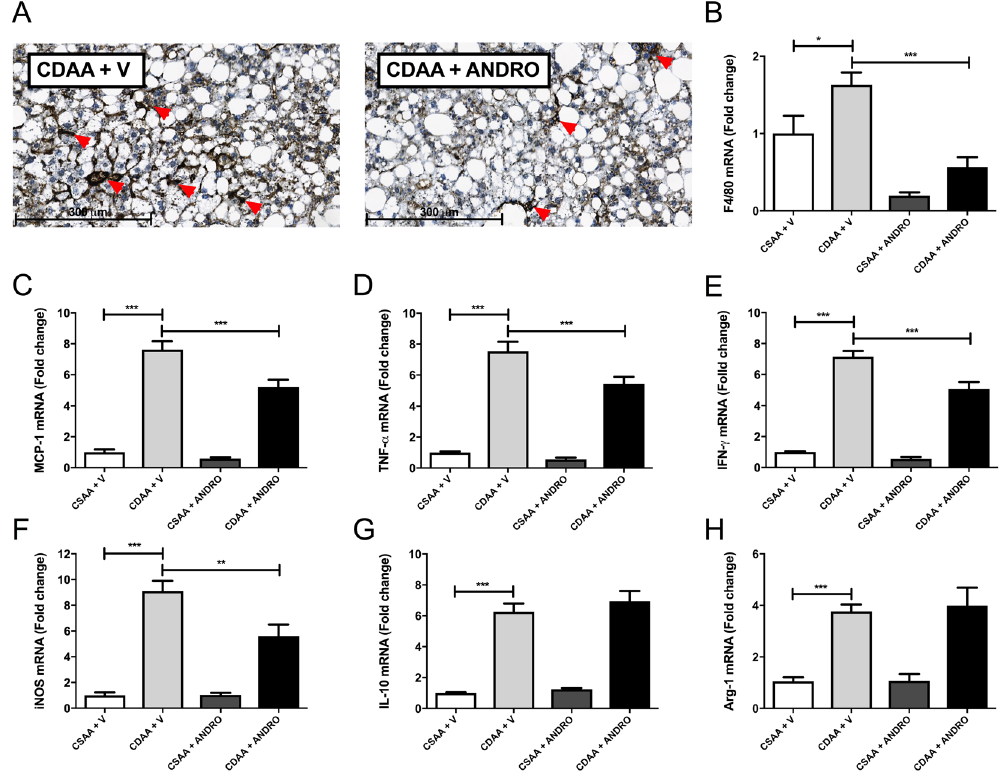
Figure 4. Andrographolide (ANDRO) alleviates CDAA-diet-induced inflammation. Mice were fed with choline-deficient amino acid-defined (CDAA) or choline-supplemented L-amino acid defined (CSAA) diets during 22 weeks and treated with ANDRO or Vehicle (V) as described in material and methods. ( A ) Immunohistochemistry of liver sections using anti-F4/80 antibody, red arrows show inflammatory foci. Hepatic mRNA levels of (B) F4/80, (C) Monocyte chemotactic protein 1 (MCP-1), (D) Tumor necrosis factor-alpha (TNF- α ), (E) Interferon gamma (IFN γ ), (F) inducible nitric oxide synthase (iNOS), (G) interleukin-10 (IL-10) and (H) arginase-1 (Arg-1) were also assessed by real time-PCR. Statistical significance was evaluated using ANOVA with a post-hoc Bonferroni multiple-comparison test ( * p ≤ 0.05, ** p ≤ 0.01 and *** p ≤